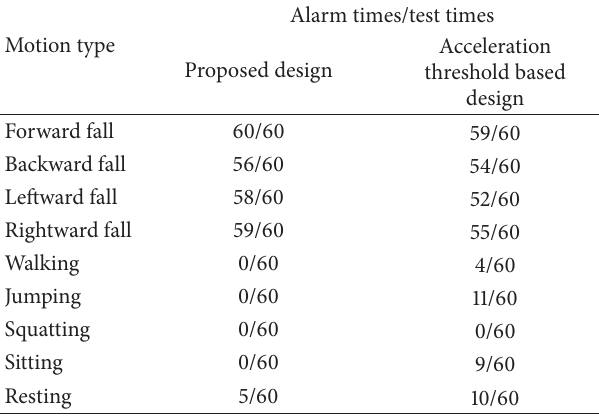
Table 1: Test results for four kinds of falling and five kinds of